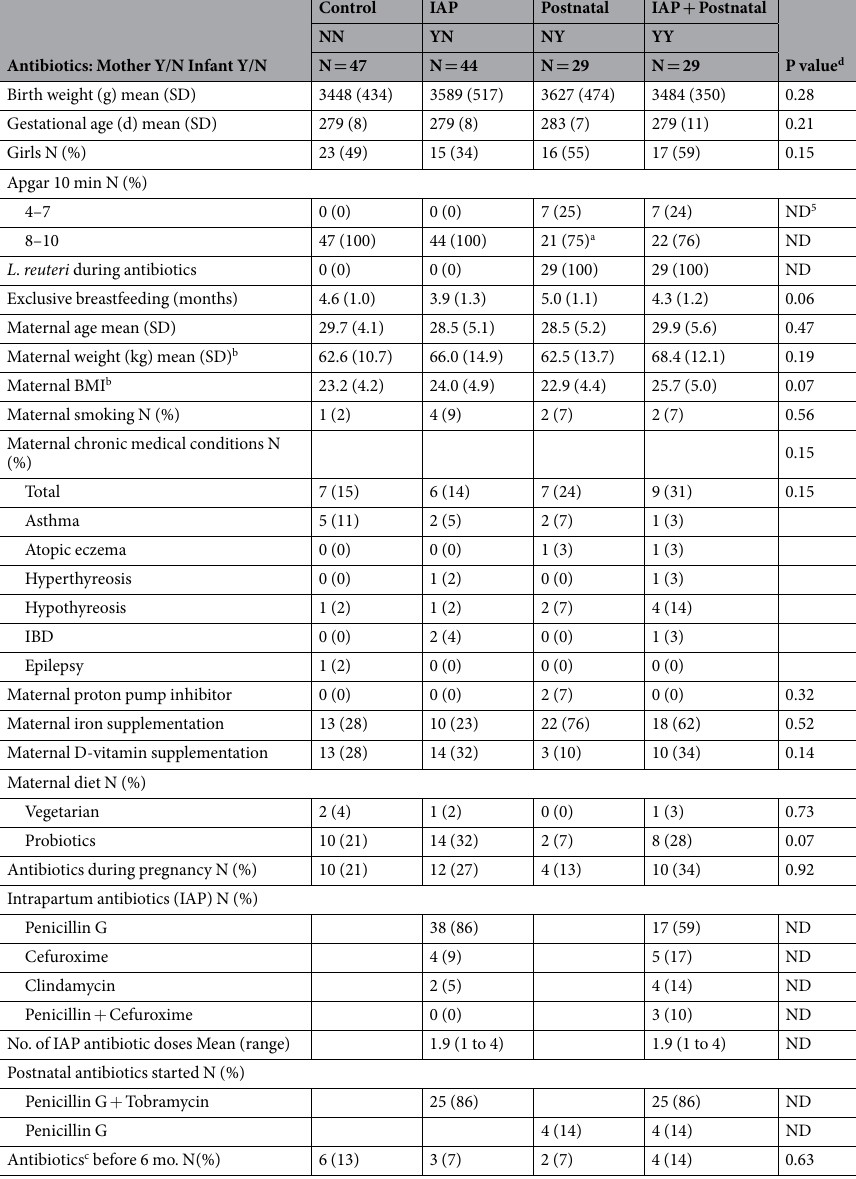
Table 1. Background characteristics of study participants. IAP indicates intrapartum antibiotics prophylaxis. Y = Yes, N = No. a One infant had a missing Apgar value at 10 minutes. b In the first trimester of pregnancy, BMI body mass index (normal values 20–25). c Mainly β -lactam antibiotics given during infancy for respiratory infections of the infants, including amoxicillin (N = 6), amoxicillin-clavunate (N = 4), cefuroxime or ceftriaxone (N = 2). d P value indicates the statistical significance of variance analysis for continuous variables, i.e. the difference between all groups, and that of Pearson chi-square test for categorical variables. ND statistical testing not done as the groups were originally created based on these differences in perinatal antibiotic use. Furthermore, postanatal antibiotics were given only for newborn infants with clinical problems after birth reflected by low Apgar points. Lactobacillus reuteri was given only for infants on postnatal antibiotics as a part of their routine clinical care according to the local